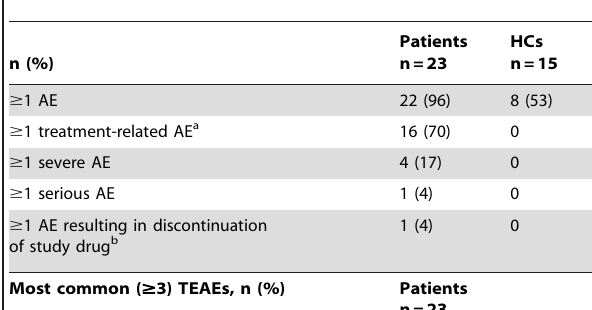
Table 6. Adverse event